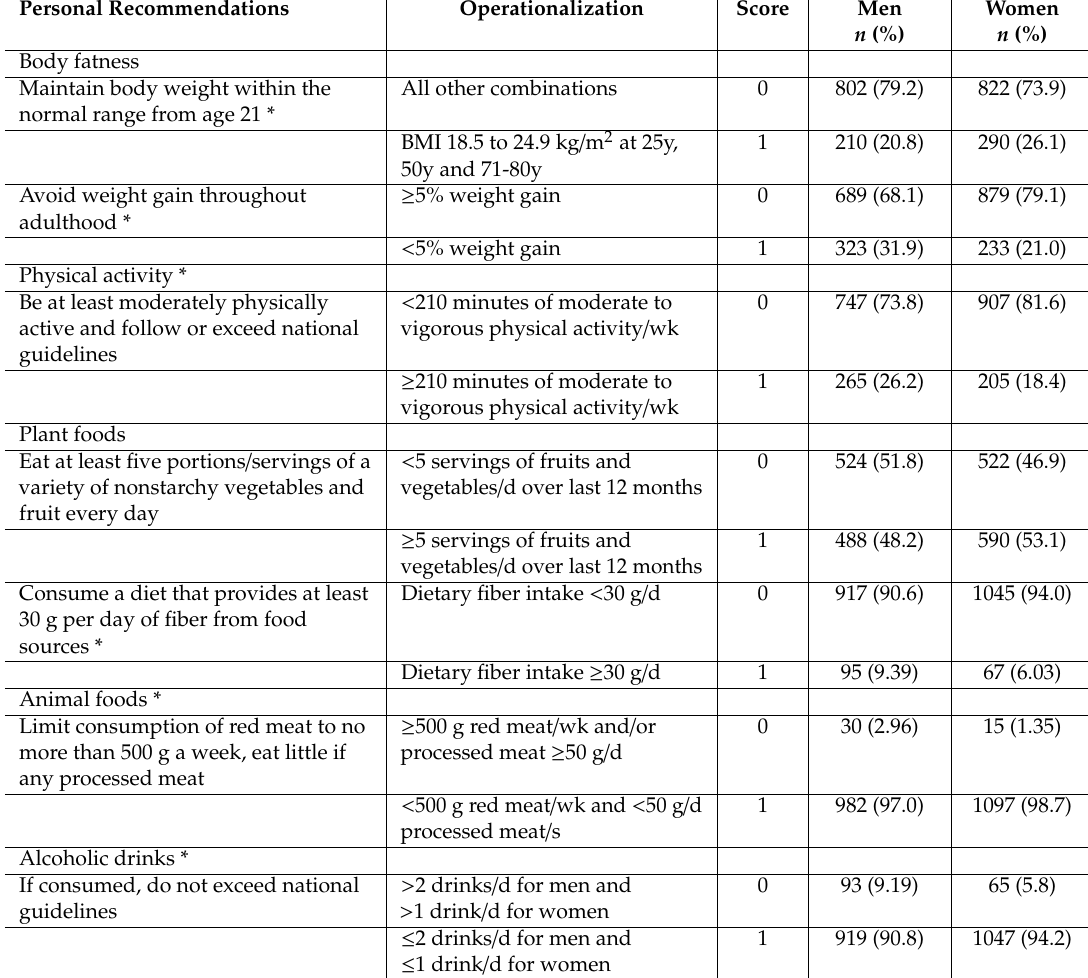
Table 1. WCRF / AICR personal recommendations for cancer prevention and translation to adherence score in the Health ABC